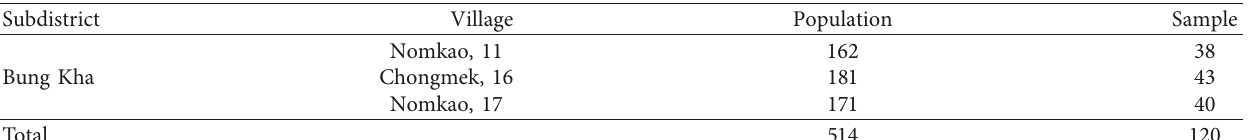
Figure 10: Simulated land use maps for 2018–2067 above the Huay Ling Jone area. (a) Year 2024. (b) Year 2038. (c) Year 2052. (d) Year 2066. (e) Year 2067. Table 6: The population and sample used in the study of the Huay Sabag.